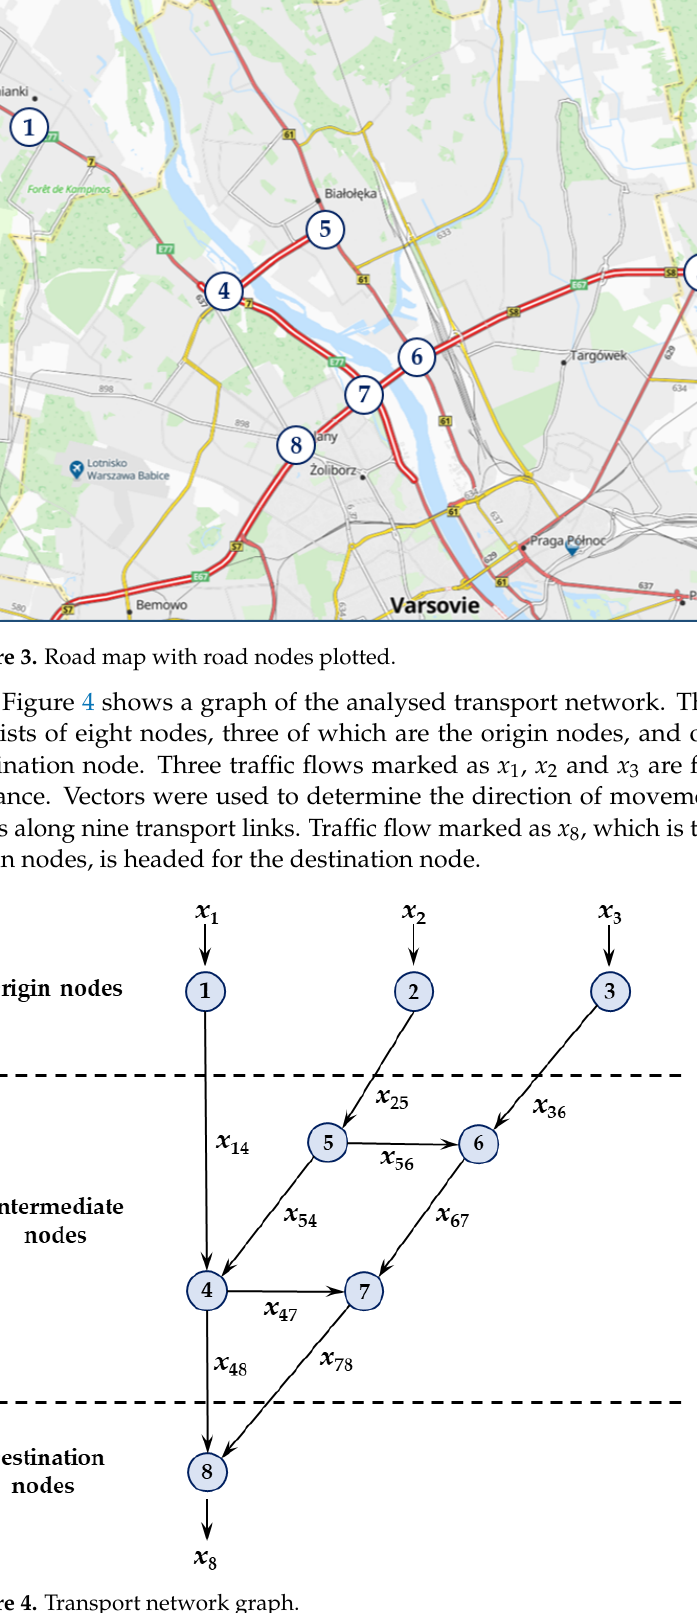
Figure 4. Transport network Figure 4. This is a figure. Schemes follow the same formatting. If there are multiple panels, they should be listed as: ( a ) Description of what is contained in the first panel. ( b ) Description of what is contained in the second panel. Figures should be placed in the main text near to the first time they are cited. A caption on a single line should be centered.